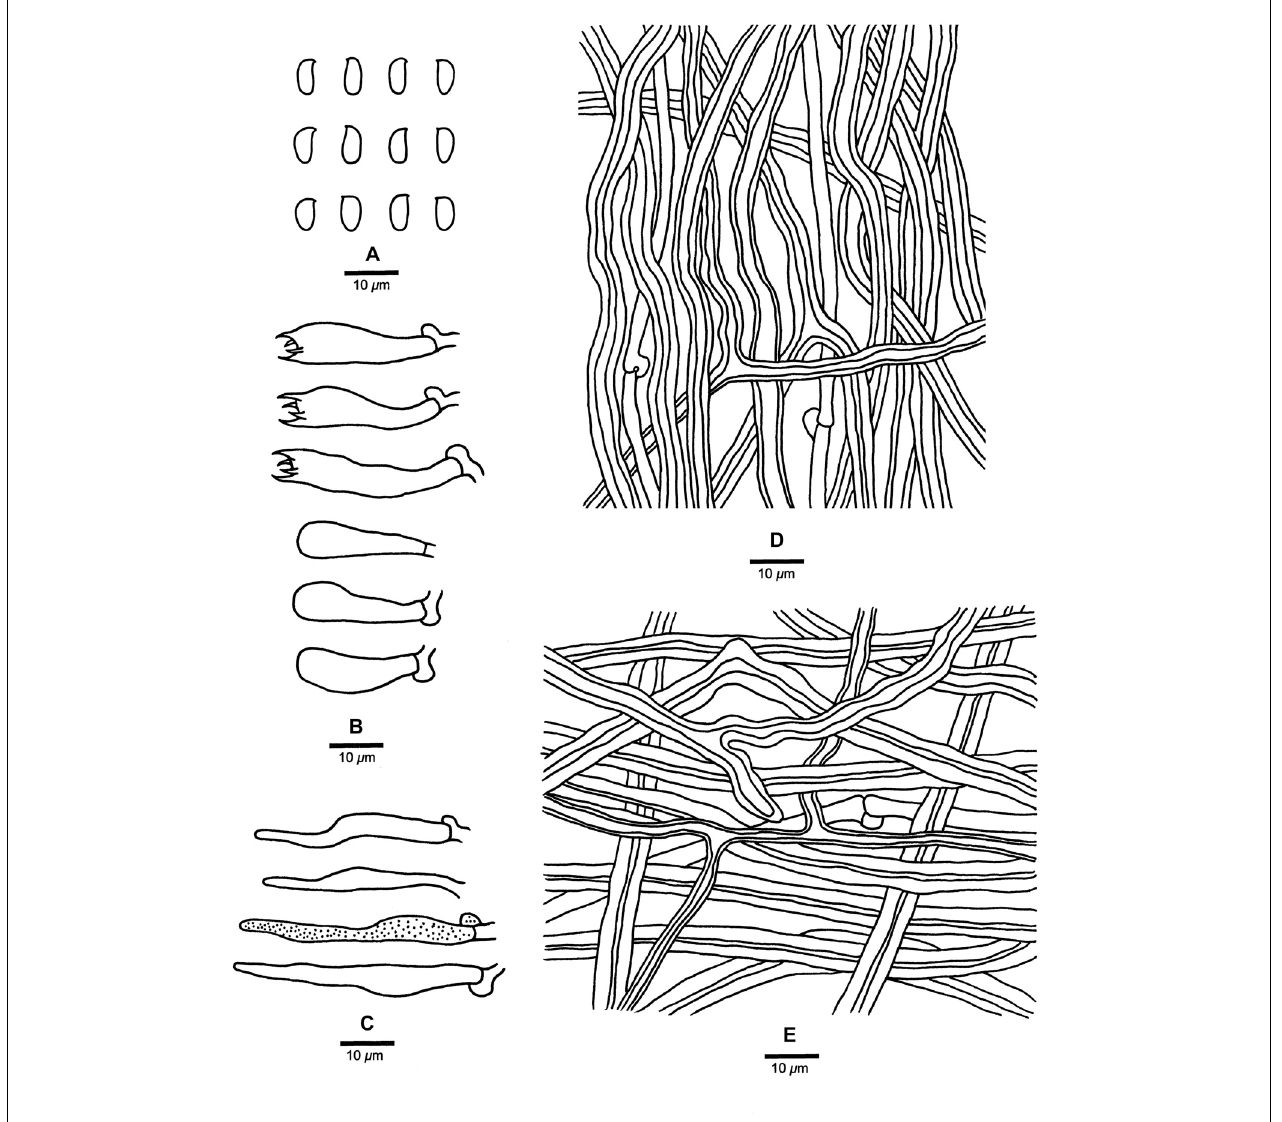
FIGURE 9 | Microscopic structures of Fomitopsis tianshanensis (drawn from the holotype). (A) Basidiospores; (B) Basidia and basidioles; (C) Cystidioles; (D) Hyphae from trama; (E) Hyphae from context. Bars: A–E = 10 µ